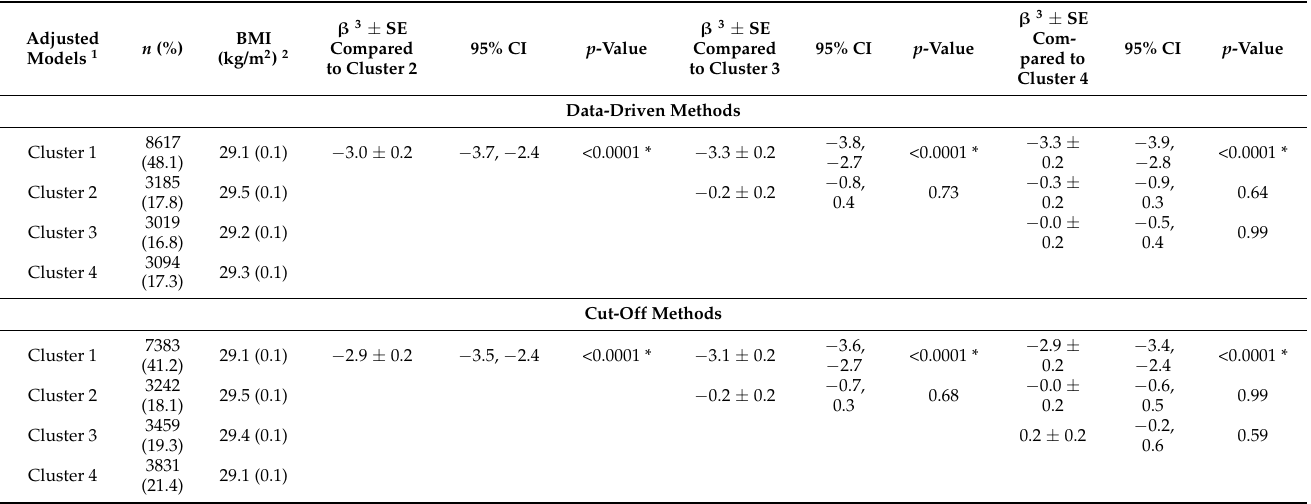
Table 3. Adjusted regression model results for mean BMI (kg/m 2 ) with clusters representing TDPs of U.S. adults 20–65 years as drawn from the NHANES, 2007–2016, generated based on data-driven methods and cut-off methods.